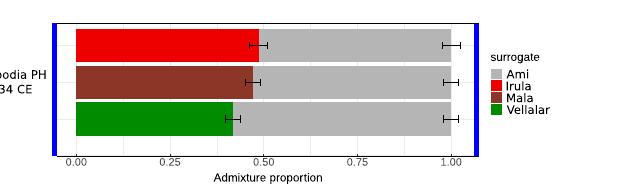
Figure 5. A biplot of outgroup f 3 -statistics. The plot of f 3 (Mbuti; Vellalar, X) vs. f 3 (Mbuti, Dai, X), where X is an ancient individual from Southeast Asia or present-day populations from East, Southeast, or South Asia. The plot demonstrates shared genetic drift between population X and Vellalar (a SAS population) or Dai (an ESEA population). The trend line illustrates the ratio of genetic drift sharing between most ESEA populations and the SAS and ESEA surrogate. Abbreviations: N Neolithic, LN Late Neolithic, PH Protohistoric period, BA Bronze Age, His. Historical period.